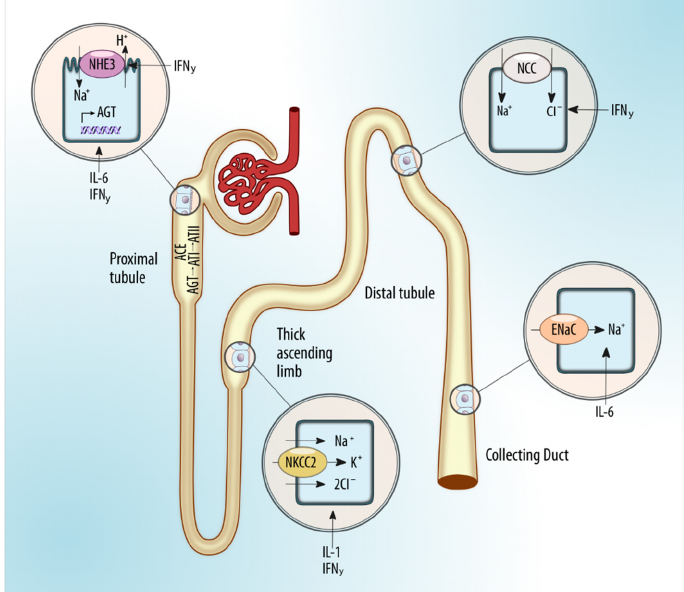
Figure 1. The complex interplay at renal tubule between sodium, tubular transporters, and Figure1. Thecomplexinterplayatrenaltubulebetweensodium, tubulartransporters, andinflammatory inflammatory cytokines [22–24]. Abbreviations: AGT, angiotensinogen; ATI, angiotensin I; cytokines [22–24]. Abbreviations: AGT, angiotensinogen; ATI, angiotensin I; ATII, angiotensin II; ATII, angiotensin II; ACE, angiotensin-converting enzyme; NHE3, sodium/hydrogen ACE, angiotensin-converting enzyme; NHE3, sodium / hydrogen exchanger 3; IFN- γ , interferon- γ ; exchanger 3; IFN- γ , interferon- γ ; IL-6, interleukin-6; NKCC2, sodium-potassium-two IL-6, interleukin-6; NKCC2, sodium-potassium-two chloride cotransporter; NCC, sodium-chloride chloride cotransporter; NCC, sodium-chloride cotransporter; ENaC, epithelial sodium channel; IL-1, interleukin-1. cotransporter; ENaC, epithelial sodium channel; IL-1,